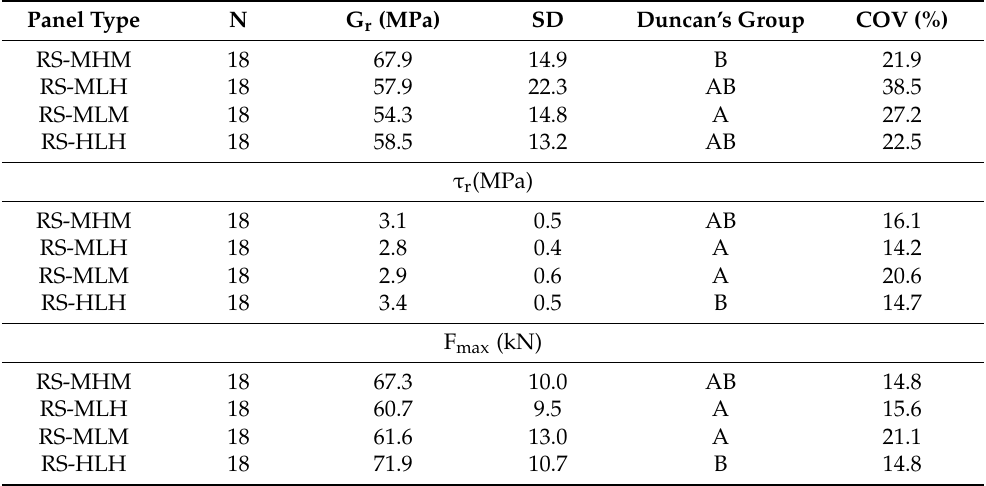
Table 3. Mean values of different variables from the test